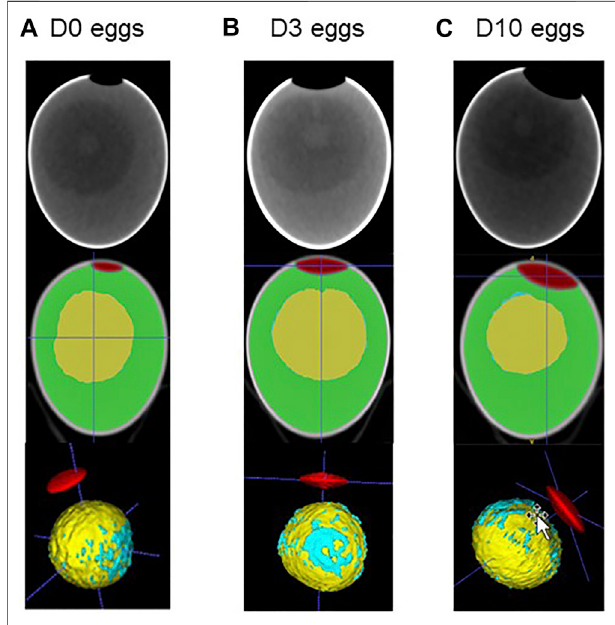
FIGURE 3 | CT imaging of fertilised eggs stored for zero, three or 10 days (D0 (A) , D3 (B) and D10 (C) , respectively). Using ITK. snap tool (Yushkevich et al., 2006), images obtained after CT imaging (upper panel) were analysed for 3D reconstruction, segmentation and coloured for illustration. Theair chamber isillustrated inred, the yolk isshown in yellow, the white in green and the blastoderm in blue. It is noteworthy that for the latter parameter, we considered all blue spots distributed on the yolk surface to avoid any bias between groups. A concentration of blue spots that likely corresponds to the blastoderm is clearly visible, while blue spots are also sporadically distributed on the yolk surface.